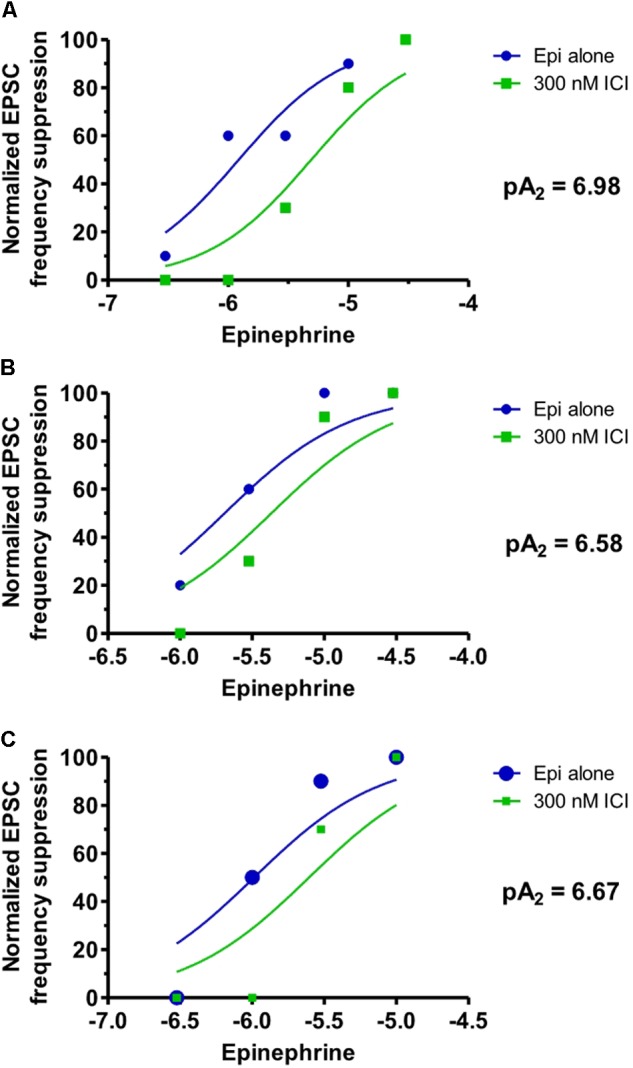
ICI-118,551 blocked the suppressant action of epinephrine on late EPSPs evoked by electrical stimulation/DOI. The shift in the epinephrine concentration-response suppression in the frequency of late EPSPs induced by electrical stimulation/DOI is shown for three cells (A–C) before and during bath application of the β-adrenergic receptor antagonist ICI-118,551 (300 nM). The pA2 calculated for each cell using the Schild equation is displayed for each cell.